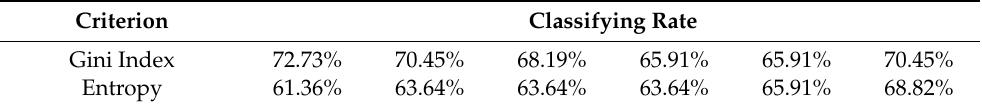
Figure 10. Decision tree of sorting class IDs in entropy criterion (depth = 3). Figures 9 and 10 are two methods to decide nodes of the decision tree. The decision tree may be overfitting when the amount of data is too small. To obtain a higher accuracy, two splitting methods are carried out. The result of the decision tree shows that two sorting methods have high accuracy (higher than 60%). Table 6. Accuracy of the classification rate of the two criterion methods.